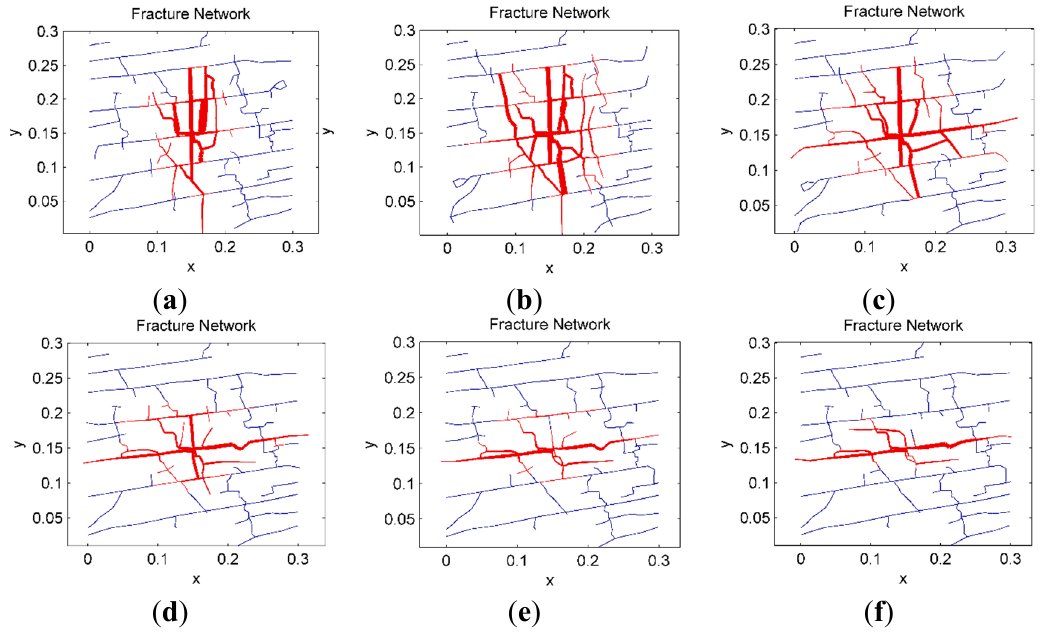
Figure 12. The final fracture networks. The fractures affected by the fluid injection are colored red and other fractures are colored blue: ( a ) σ ( b ) σ (cid:3398) σ (cid:3404) (cid:3398)6 MPa , (cid:1845)(cid:1827) (cid:3051) (cid:3052) ( d ) σ (cid:3398) (cid:2026) (cid:3404) 2 MPa , (cid:1845)(cid:1827) (cid:3051) (cid:3052) (cid:3404) 3.3 10 MPa , (cid:1845)(cid:1827) (cid:3051)(cid:3052)